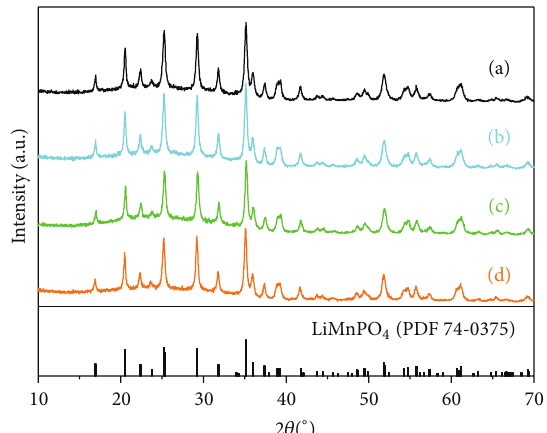
Figure 5: XRD pattern for LiMnPO 4 synthesized with various parameters: (a) 190 ∘ C [H 2 O]/[Mn] = 30 (sample B), (b) 190 ∘ C [H 2 O]/[Mn] = 15 (sample E), (c) 150 ∘ C [H 2 O]/[Mn] = 30 (sample F), and (d) 150 ∘ C [H 2 O]/[Mn] = 15 (sample G).